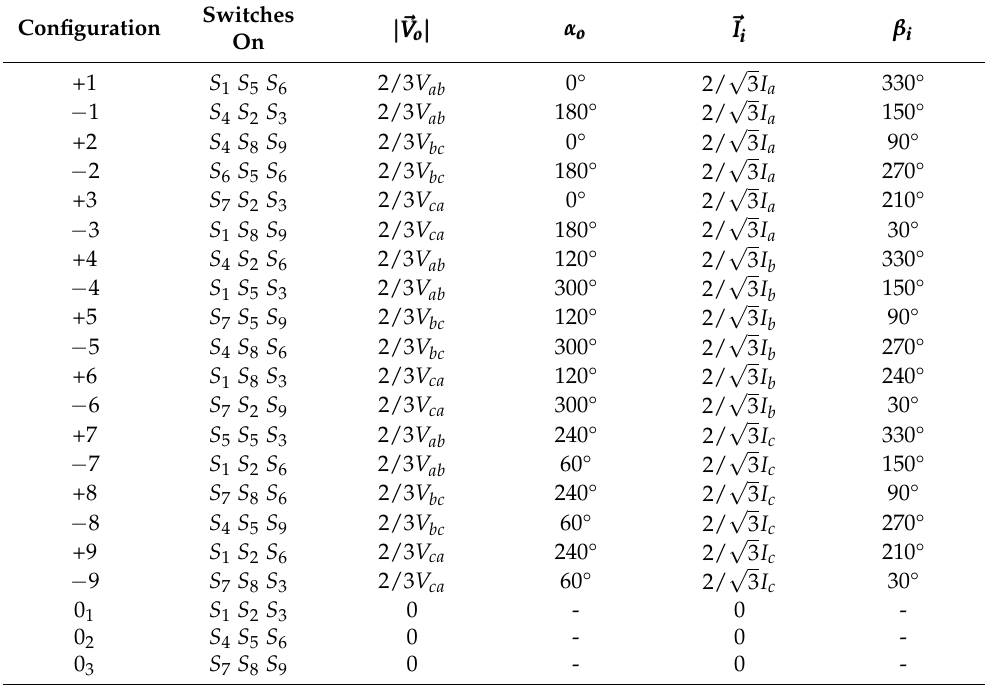
Table 1. Switching configurations in the SVM algorithm.